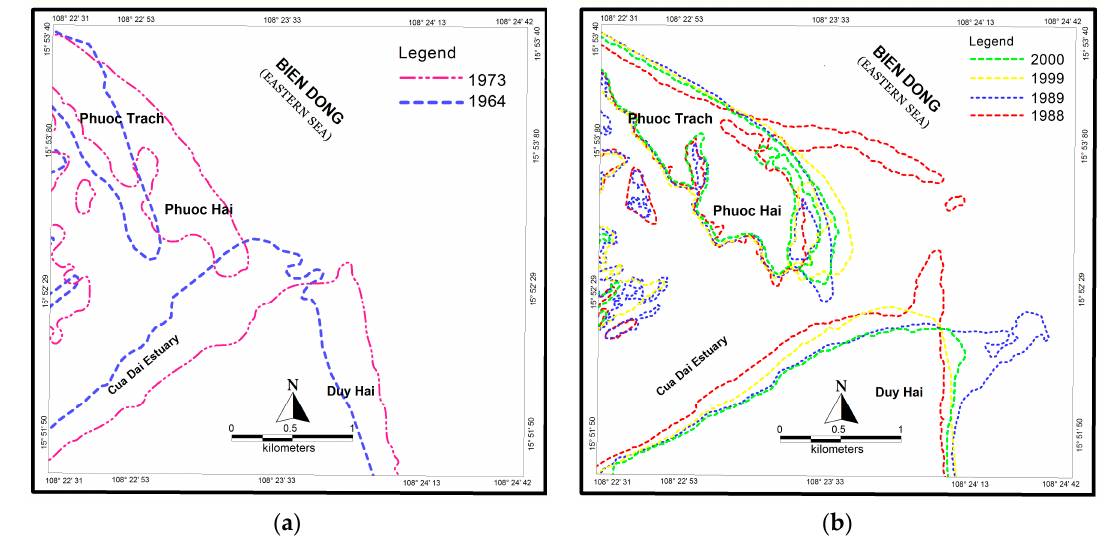
Figure 3. The historical shoreline morphological changes of the Cua Dai estuary ( a ) between 1964 and 1973, and ( b ) between 1988 and 2000 are shown in different line patterns and colors.